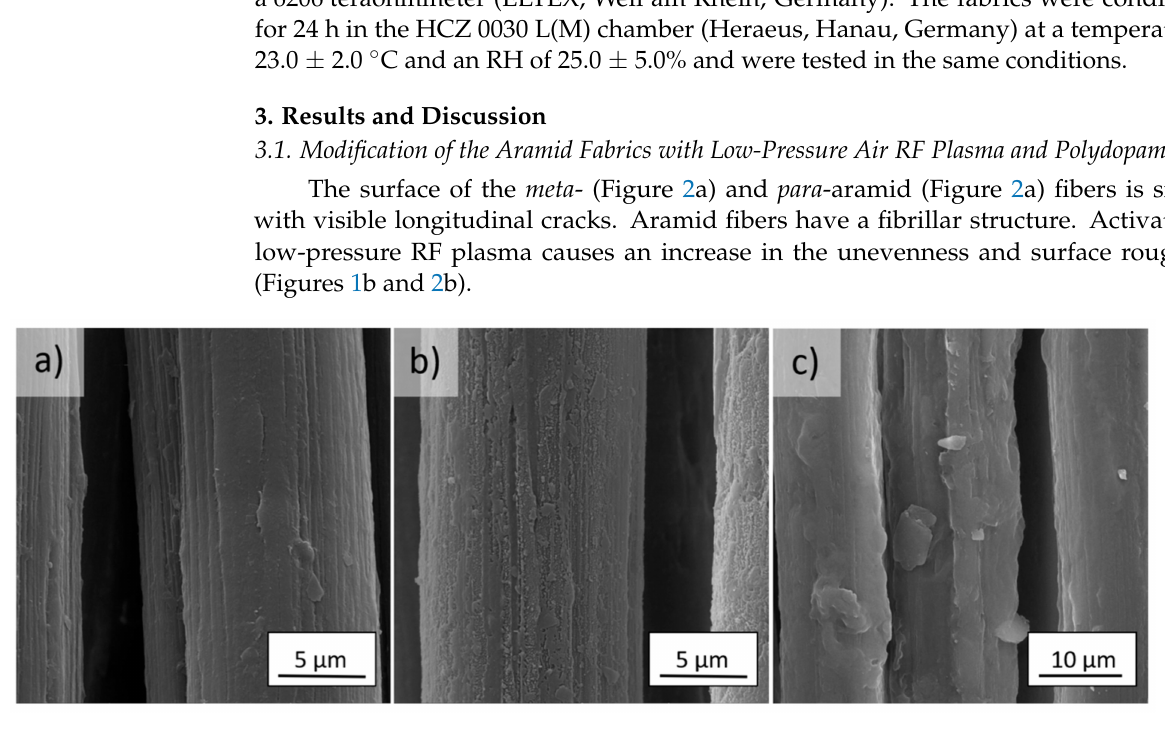
Figure 2. SEM images of ( a ) reference, ( b ) plasma treated, and ( c ) polydopamine modified m Ar fibers (magnification of 10,000 × ).